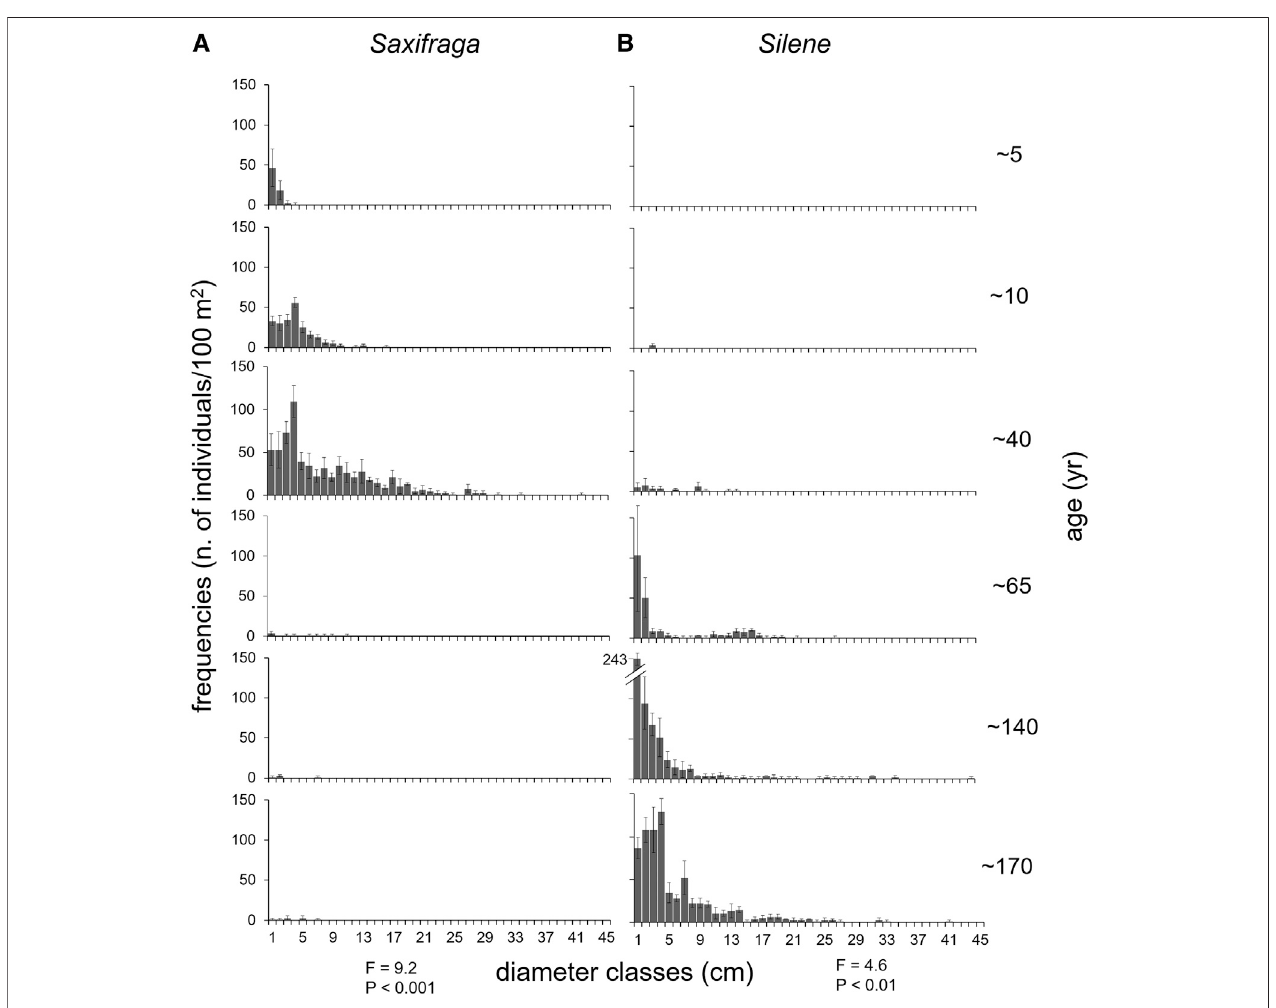
FIGURE 4 | Population structure (distribution frequencies of individual diameters) in each stage of the chronosequence for the two target species Saxifraga oppositifolia L.subsp. glandulifera Vacc. (A) and Sileneacaulis (L.).Jacq.subsp. bryoides (Jord.)Nyman (B) . Silene individualswerenotfoundinthe fi rststage( ∼ 5years) and are not represented. F and p indicate the results of PERMANOVA analysis among stages and within